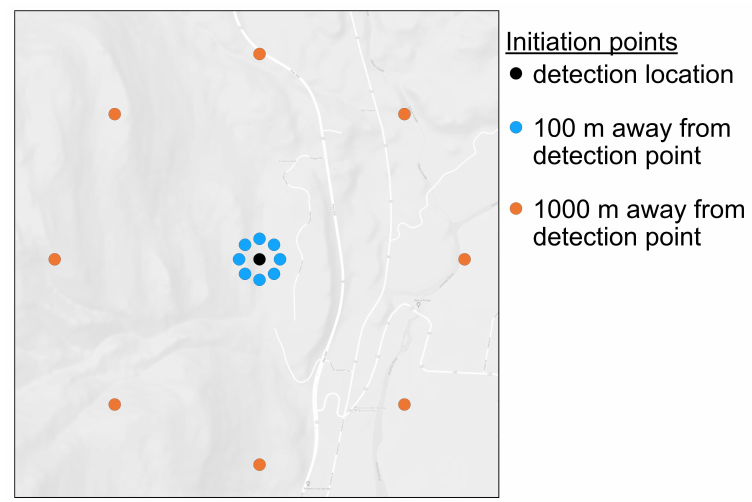
Figure 3. Configuration of derived initiation points, shown for the 416 Fire case study. The reported detection point is shown in black, derived points 100 m away are shown in blue, and 1000 m away are shown in